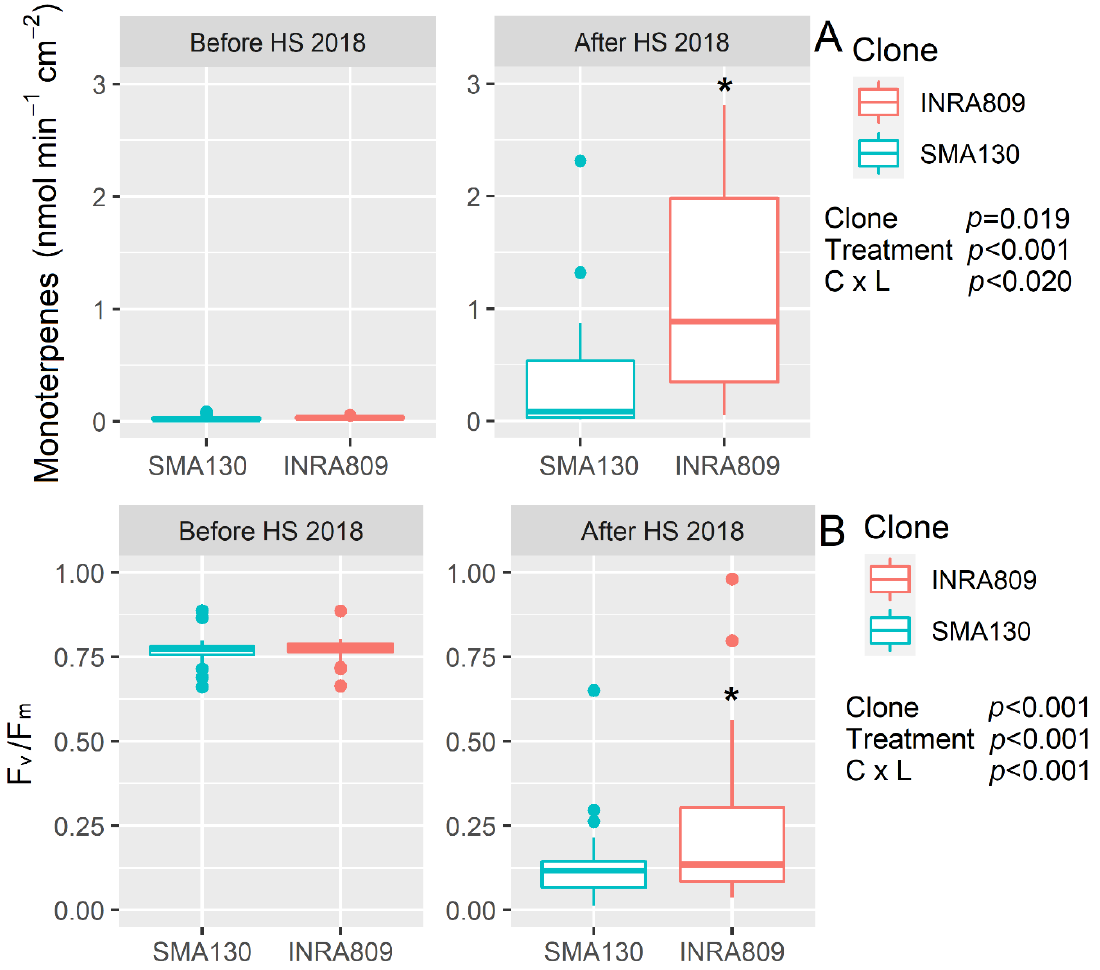
Figure 2. Monoterpenes emission ( A ) and maximum quantum yield of photosystem II in dark-adapted samples (F v /F m ) ( B ) analyzed in INRA809 and SMA130 before and after HS ( n = 20–30). Data were collected in 2018 and subjected to a two-way ANOVA. ANOVA output is shown in the figure and for each trait. Asterisks show significant differences between clones according to t -test.